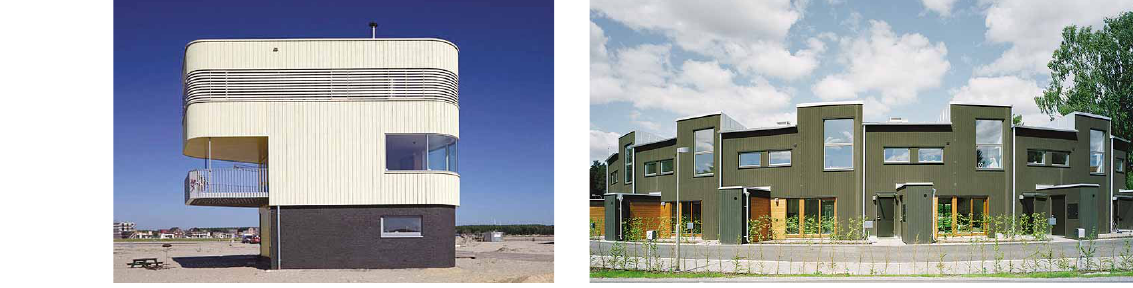
Fig. 15. Semi detached hose in Stockholm, Sweden, archit. Fig. 14. House in Almere, Holland, archit. office